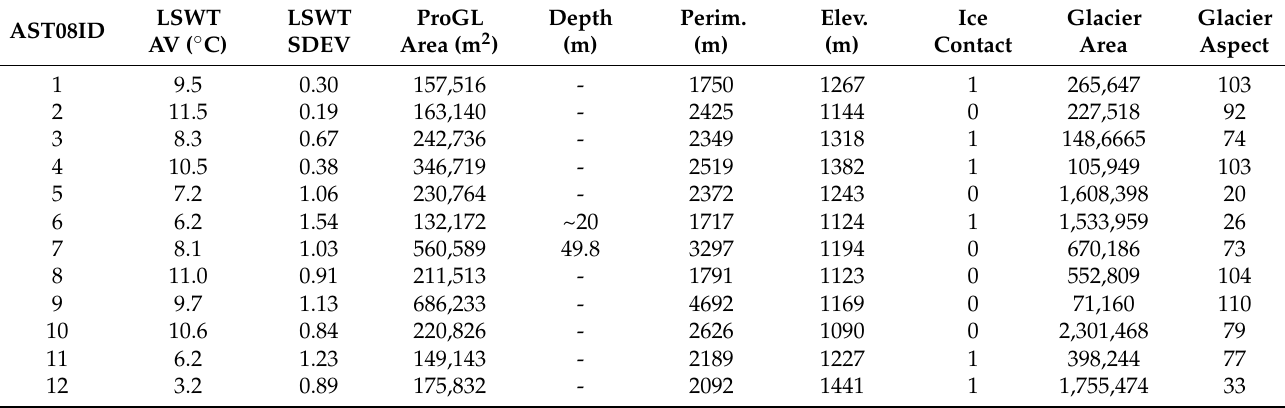
Table 1. Summary table of the 12 proglacial lakes analysed. The left columns contain the AST08 ID (as used in Figure 1) and the LSWT AV ( ◦ C) and LSWT DEV ( ◦ C) for each proglacial lake (ProGL) and associated lake geometry/characteristics from the ASTER 8 August 2014 manual mapping in central columns. Maximum depth data for lake 6 and 7 are from Dye et al. (unpublished) and [8]. Right hand columns contain geometry/characteristics of parent glaciers from the Randolph Glacier Inventory (2008). Perim. = perimeter; elev. = elevation; ice cont. = ice contact (1 =